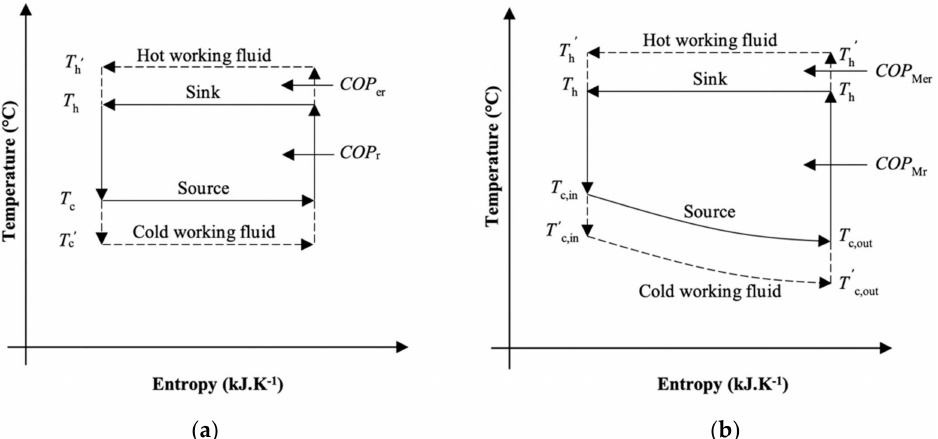
Figure 5. ( a ) Temperature–entropy diagrams of reversible (solid) and endoreversible (dashed) heat pump cycles as defined by Equations (10) and (11). ( b ) Temperature–entropy diagrams of Mr (solid) and Mer (dashed) heat pump cycles as defined by Equations